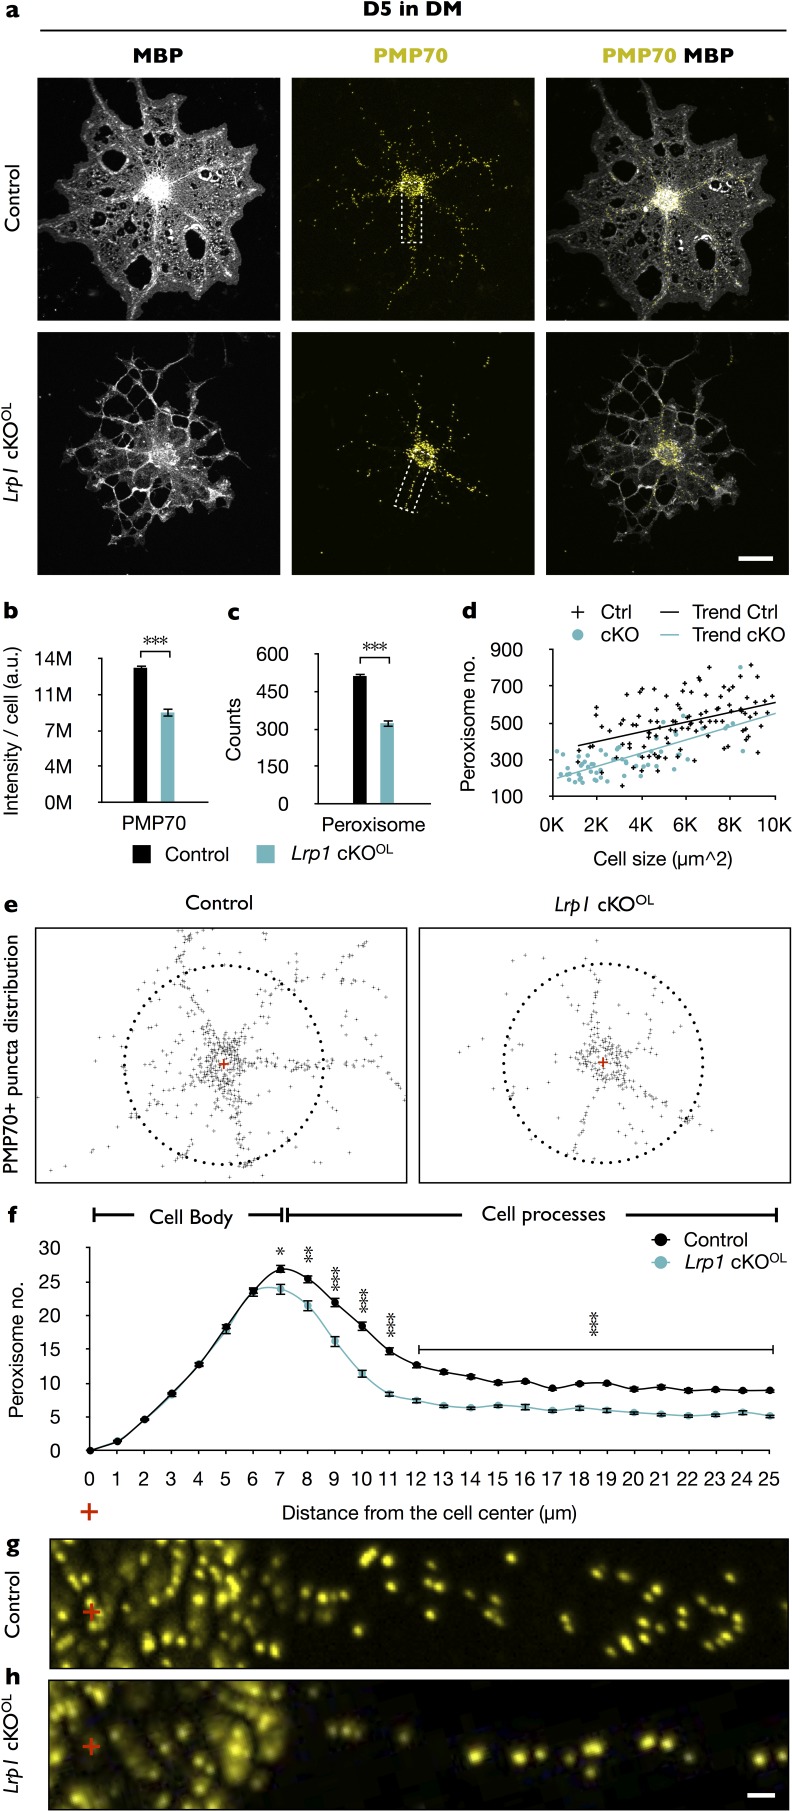
In primary OLs, peroxisome density and distribution is regulated by Lrp1.(a) Primary OLs prepared from Lrp1 control and cKOOL OL pups, cultured for 5 days in DM were stained with anti-MBP and anti-PMP70. Scale bar = 10 µm. (b–d) Quantification of PMP70 labeling intensity per cell (b), PMP70+ puncta per cell (c), and scatter plot showing the number of PMP70+ peroxisomes as a function of cell size for MBP+ OLs of Lrp1 control and Lrp1 cKOOL cultures (d). For Lrp1 control OLs, n = 112 cells from three mice. For Lrp1 cKOOL OLs, n = 60 cells from three mice. (e) Representative distribution of PMP70+ puncta of Lrp1 control and cKOOL OL. For quantification, the center of the cell was marked with a red cross. Puncta within a 25 µm radius from the center (dashed circle) were subjected to quantification. (f) Quantification of peroxisome number plotted against the distance from the center of Lrp1 control (n = 113 cells, three mice) and cKOOL (n = 63 cells, three mice) OLs. (g and h) Representative high-magnification views of PMP70+ puncta from areas boxed in panel (a). Scale bar = 1 µm. Results are shown as mean values ± SEM, *p<0.05, **p<0.01, and ***p<0.001, Student’s t-test. For a detailed statistical report, see Figure 5—source data 1.10.7554/eLife.30498.018Figure 5—source data 1.Raw data and detail statistical analysis report.